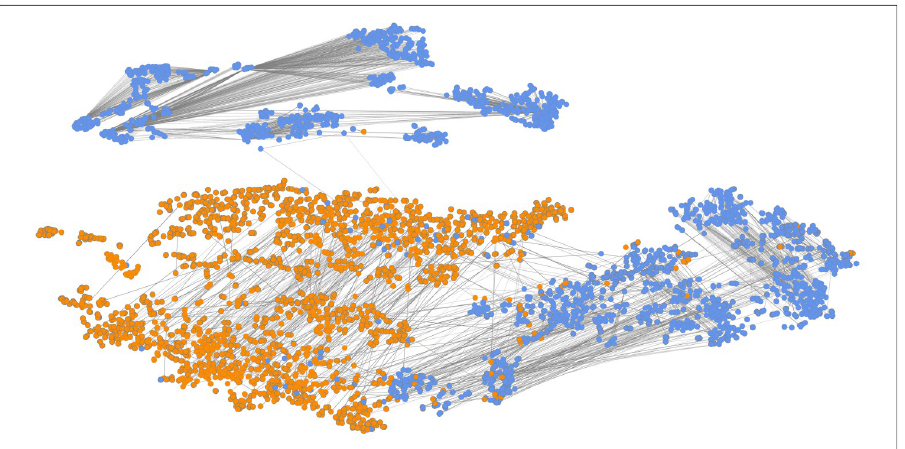
Fig 5. The visualization of the Weibo2016 posts and the weight coefficients of the meta-path PUP. The output node features obtained by the MHAN model’s attention layers are projected onto a two-dimensional plane, and the node color indicates the class of posts. The attention weight coefficients of the meta-path PUP between nodes are denoted by the edge thickness.